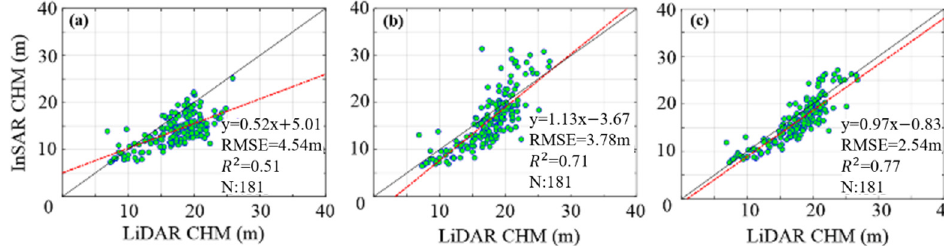
Figure 15. The estimated InSAR CHM versus LiDAR-derived CHM based on the RVoG + VTD model with: ( a ) a fixed σ ; ( b ) a fixed α vt ; and the RVoG + MTD model with: ( c ) α vt = ah v + b , where a and b can be estimated by the linear fitting between the CHM and α vt , as shown in (28).